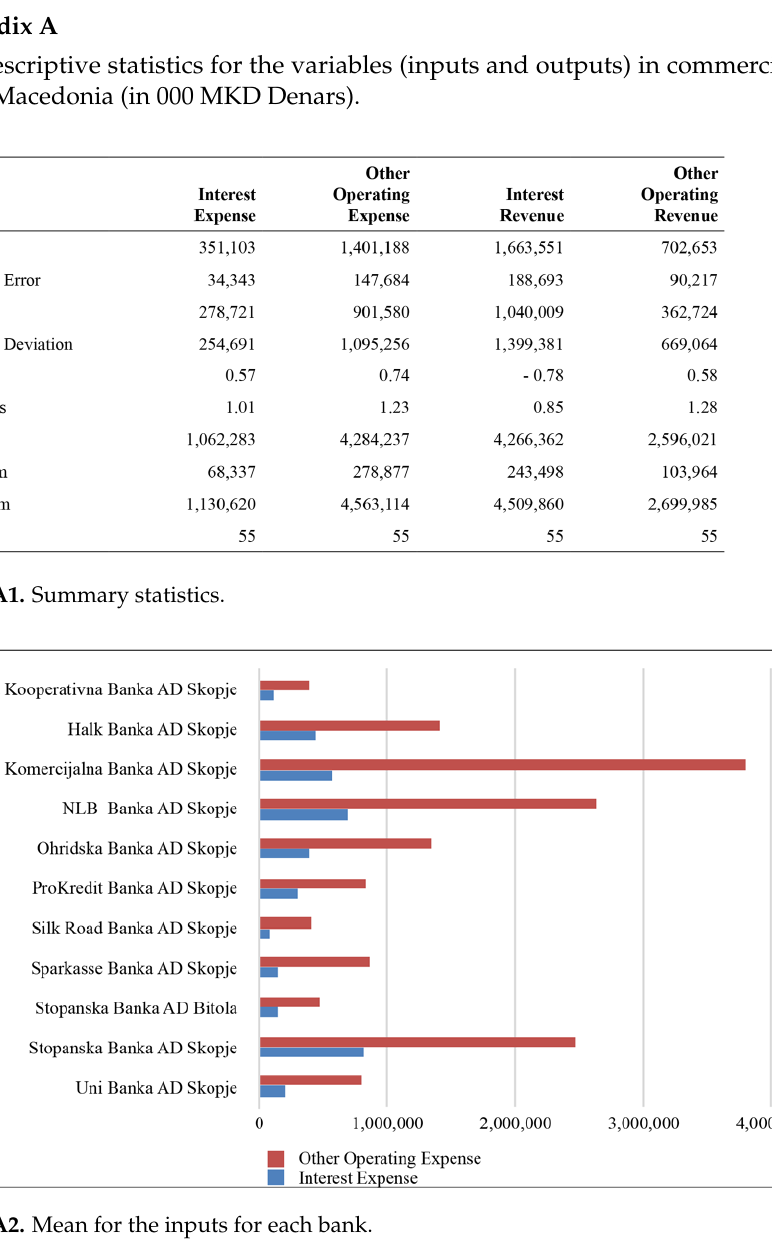
Figure A2. Mean for the inputs for each bank.